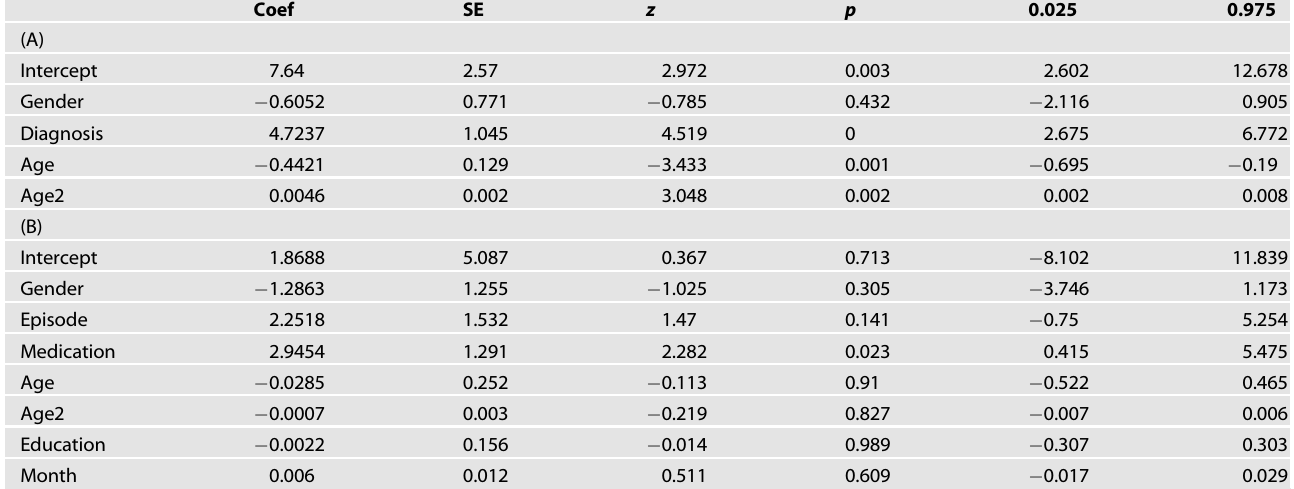
Table 2. Parameter estimates for all main effects and signi fi cant interactions in other clinical